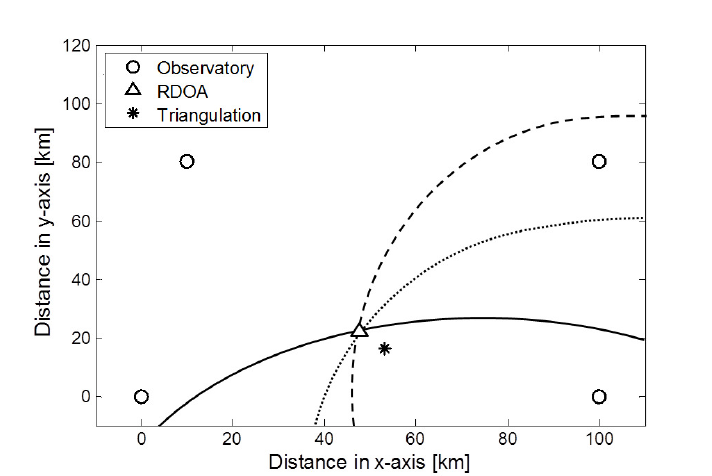
Figure 9. Epicenter location using RDOA